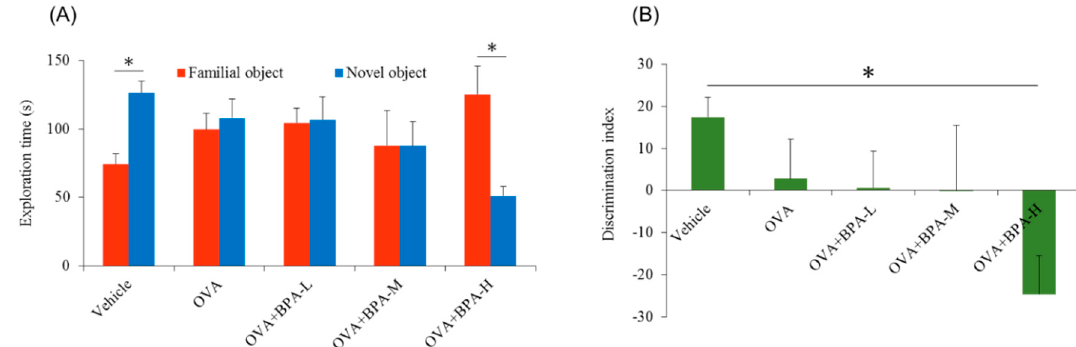
Figure 1. Illustration of possible brain–lung network in asthma. Asthma may induce brain hypoxia and cause inflammatory responses via inflammatory and oxidative stress markers and also induce cognitive impairment via hippocampal memory function related genes. Bisphenol A (BPA) exposure may enhance these effects.